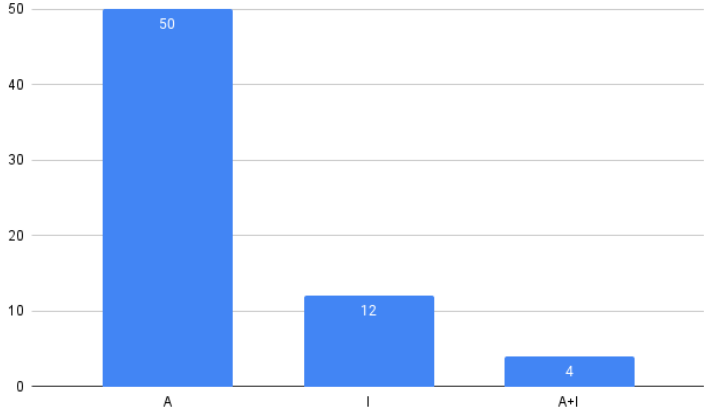
Figure 9. Origins of the proposals.